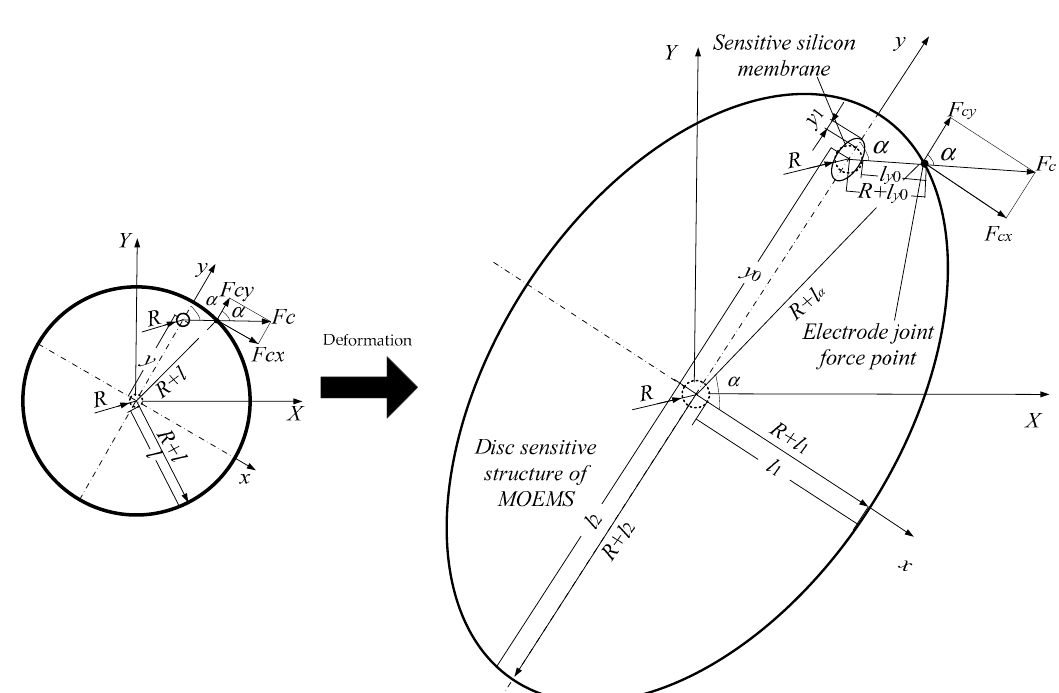
Figure 9. Schematic diagram of the force model of an elastomer